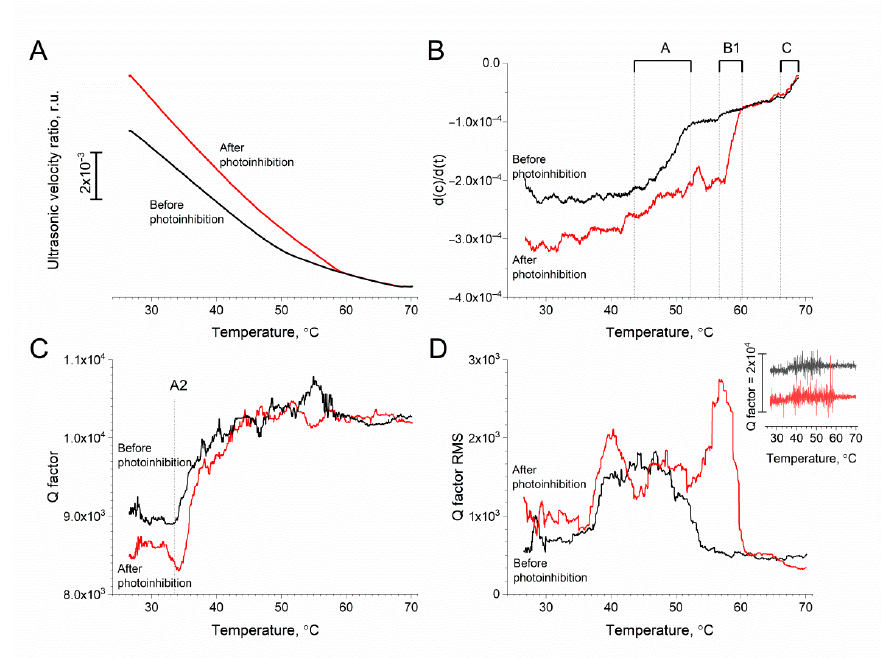
Figure 6. Ultrasound study of heat-induced damage to photosystem II core complexes before and after the photoinhibition procedure. ( A ) Relative velocity of ultrasound, ( B ) its derivative as a function of temperature, ( C ) the Q-factor, and ( D ) the Q-factor RMS as a function of temperature. Letters in ( B , C ) indicate transitions: A (43.5 °C), B1 (56.5 °C), C (66.7 °C) (the nomenclature accepted in [26] was used), and A2 (33.5 °C) (the nomenclature accepted in [28] was used).